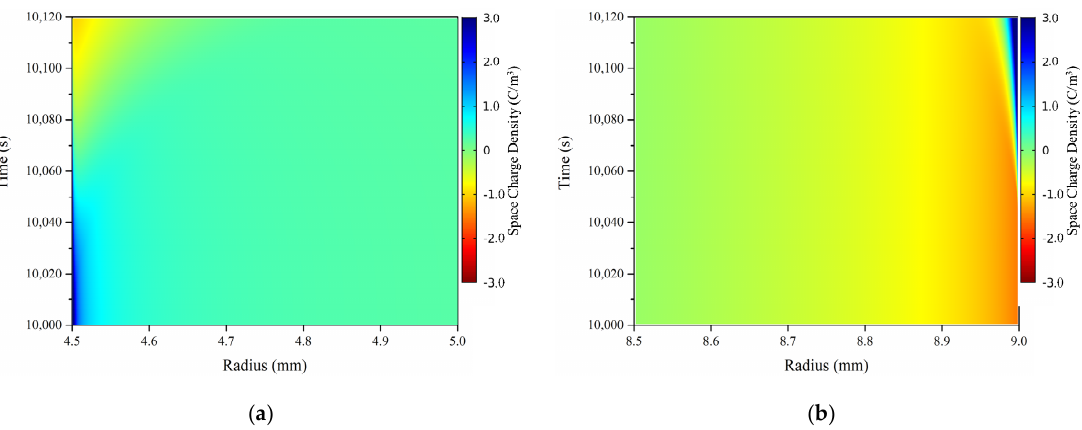
Figure 10. Space charge distribution at 350 A: ( a ) Conductor side charge density (C/m 3 ); ( b ) sheath side charge density (C/m 3 ). charge density (C / m 3 ).